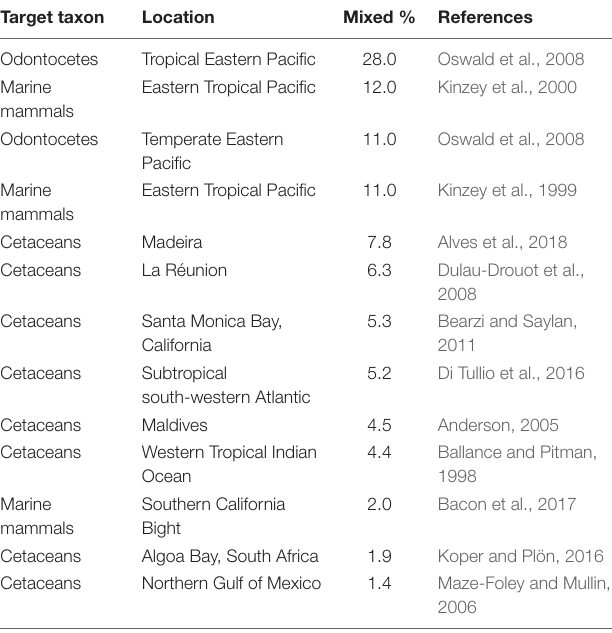
TABLE 2 | Cetacean mixed-species groups as a percentage of all groups (i.e., single- and mixed-species groups) that were observed during surveys for species belonging to the target taxa.